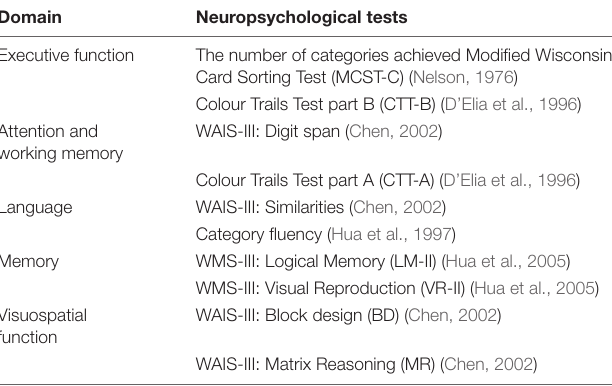
TABLE 3 | Cognitive domains and neuropsychological